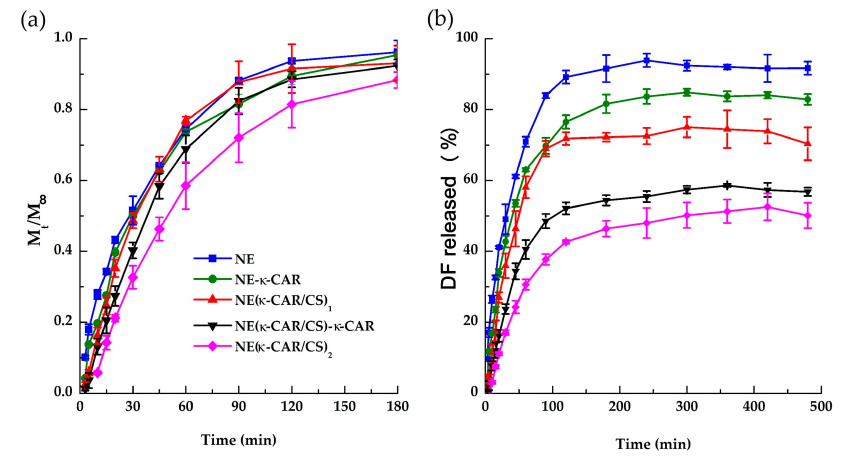
Figure 6. DF cumulative released at pH 7.4 and 37 ◦ C from nanoemulsion (NE) and nanocapsules with one (NE- κ -CAR), two [NE( κ -CAR/CS) 1 ], three [NE( κ -CAR/CS) 1 - κ -CAR], and four [NE( κ -CAR/CS) 2 ] PE layers, expressed as ( a ) M t /M ∞ and ( b ) percentage released. Standard deviation is indicated ( n =